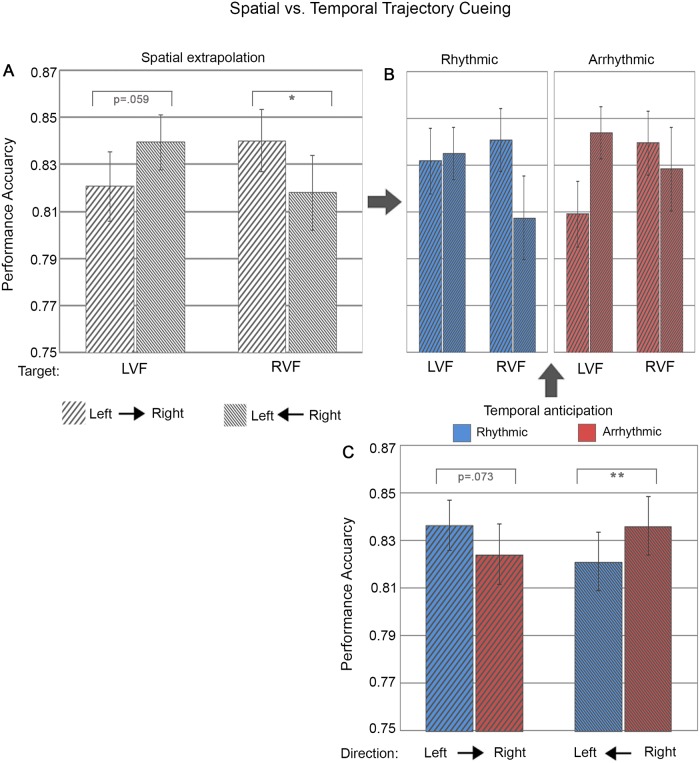
Performance accuracy as a function of spatial trajectory vs. temporal cueing conditions.(A) Bar plots represent performance during right-to-left and left-to-right motion as a function of target locations in the left visual field (LVF) and right visual field (RVF). (B) shows the same as (A) but split between the two levels of temporal cueing (i.e. rhythmic versus arrhythmic cueing). Note that the 2-way interaction of Spatial Trajectory Cueing x Target Location [illustrated in (A)] was statistically independent of temporal trajectory cueing, i.e. there was no significant 3-way interaction [illustrated in (B)]. (C) Separate bar plots for rhythmic (blue) and arrhythmic (red) cueing, per motion cueing direction, illustrating the significant 2-way interaction between temporal trajectory cueing and motion cueing direction. The error bars indicate standard error of the means (± SE). ‘*’: represent simple tests significant at p<0.05 and ‘**’ at p<0.01.